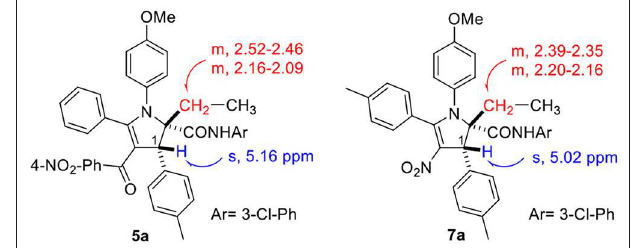
FIGURE 1 | NMR features of